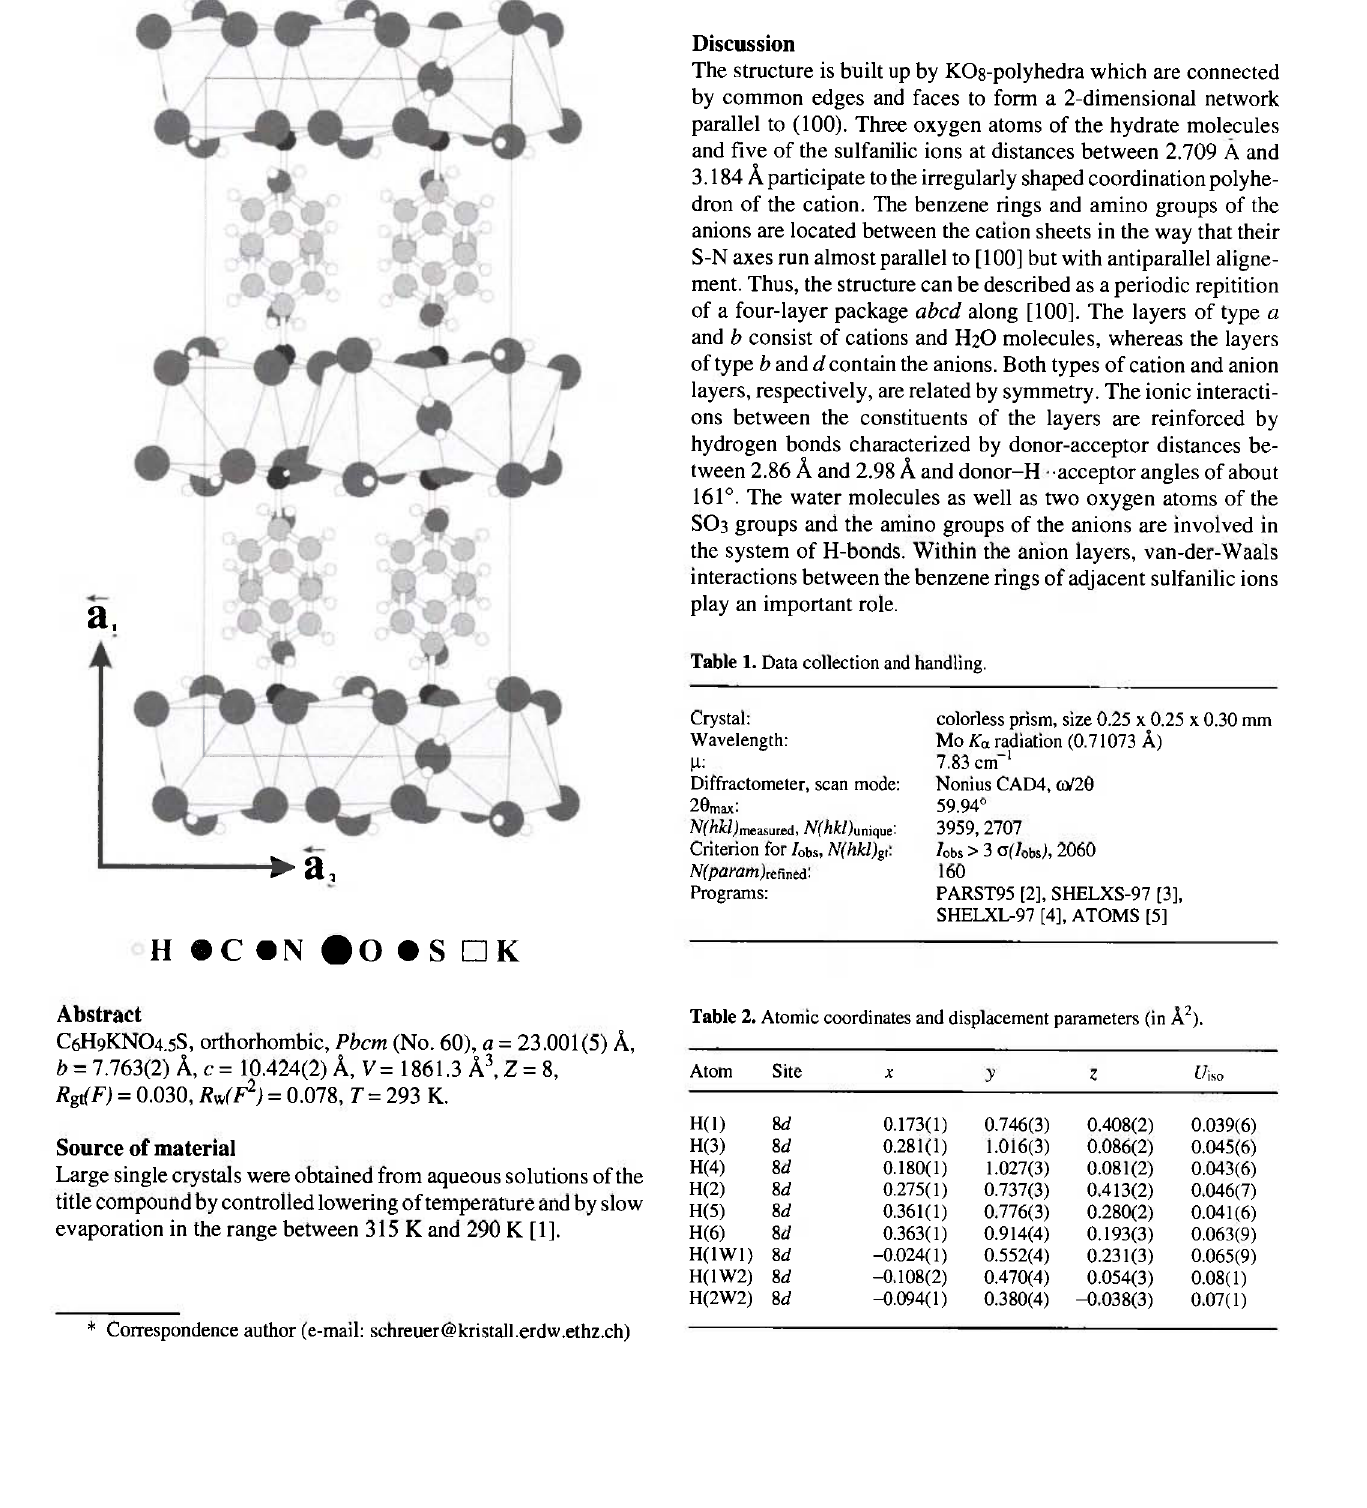
Table 2. Atomic coordinates and displacement parameters (in Ä 2